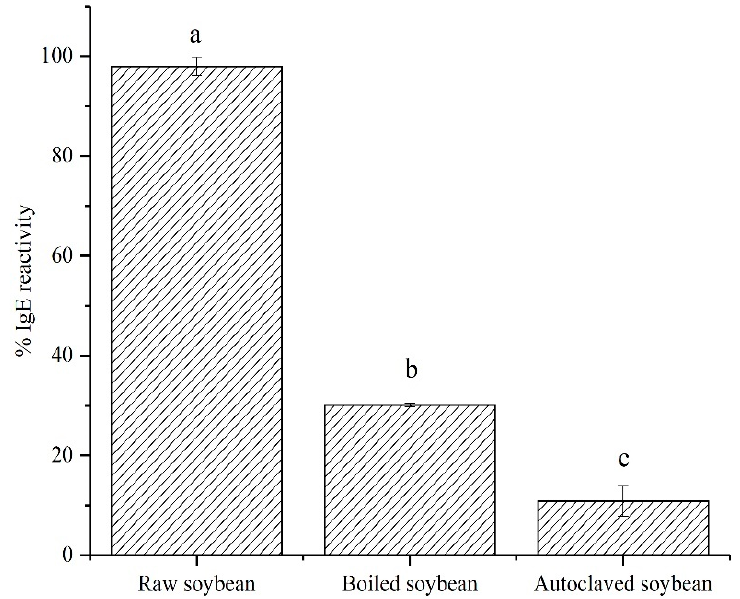
Figure 1. Changes in IgE binding capacity of extracted proteins from raw, boiled and autoclaved soybeans. Means with different letters ( a – c ) indicate significantly different ( p < 0.05).